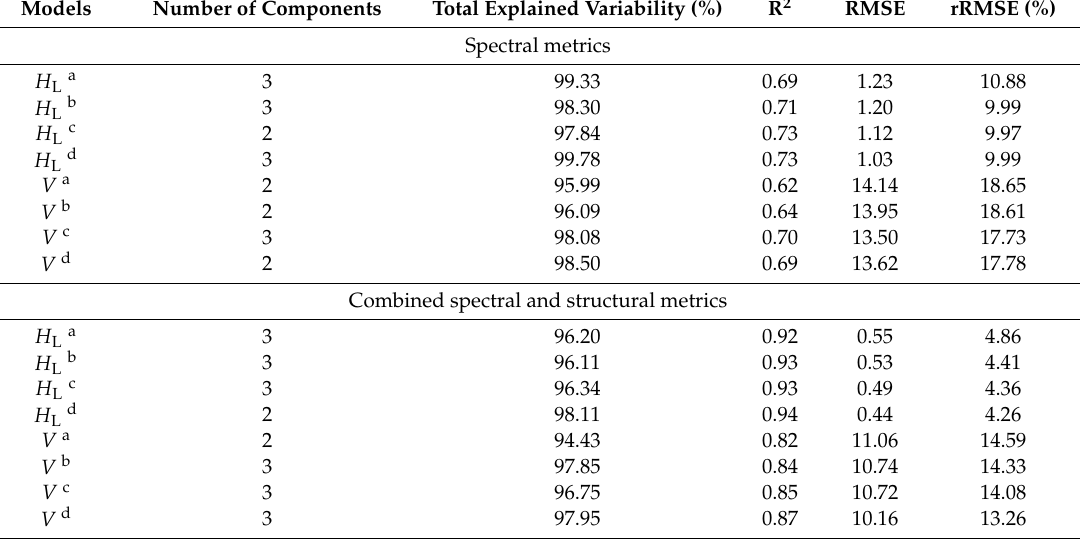
Table 5. Summary of the forest structural attribute prediction models with spectral and structural metrics derived from UAS multispectral imageries and the DAP point cloud. The best models based on the standard error of the cross-validation residuals are displayed with the number of components, total explained variability (%), cross-validated coefficient of determination (R2), cross-validated Root-Mean-Squared-Error (RMSE), and relative RMSE (rRMSE). Models Number of Components Total Explained Variability (%) R 2 RMSE rRMSE (%) Spectral